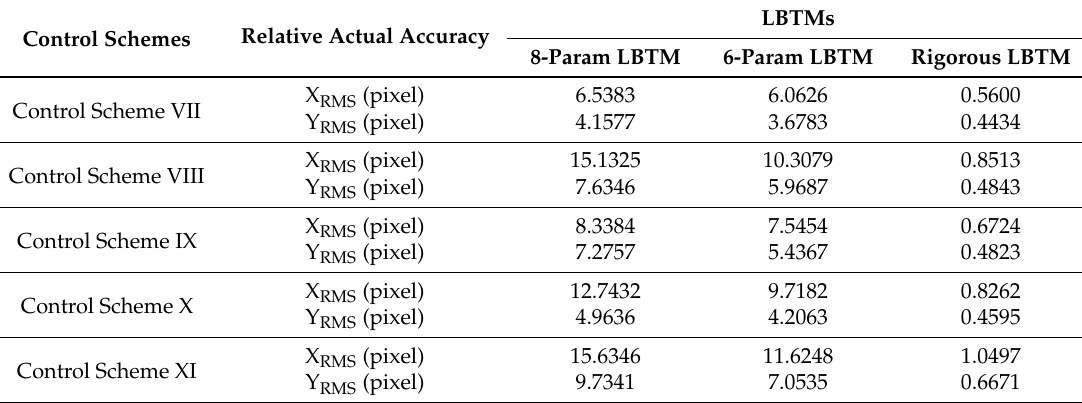
Table 5. Relative actual accuracy of Control Schemes VII to XI by different